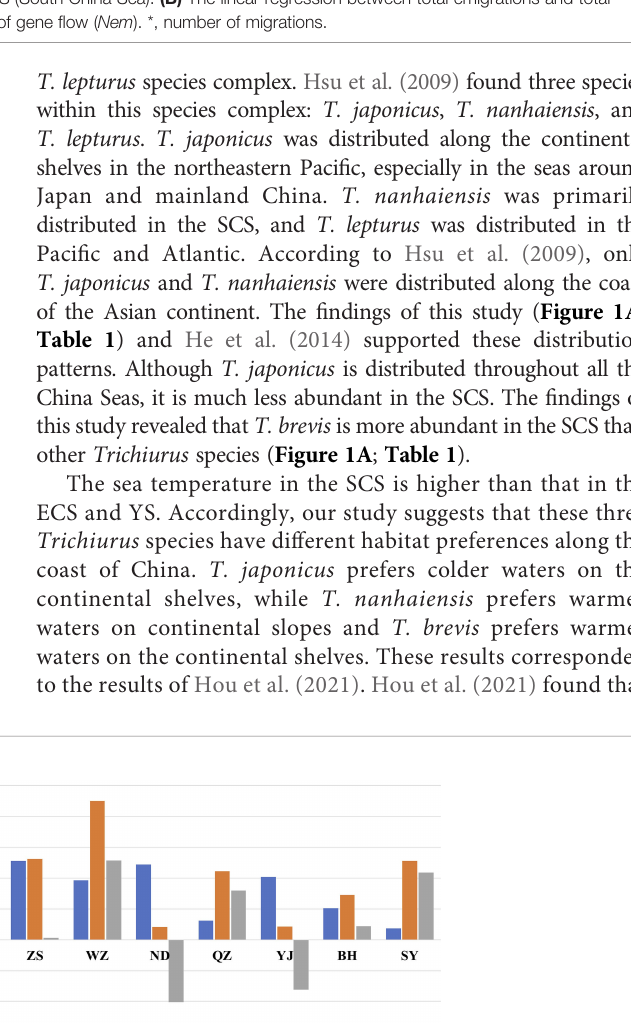
FIGURE 4 | The results of the analysis of the MIGRATE-N of Trichiurus japonicus . (A) Migration model diagrams. Arrows represent directions of gene fl ow among the three oceanographic groups, YS (Yellow Sea), ECS (East China Sea) and SCS (South China Sea). (B) The linear regression between total emigrations and total